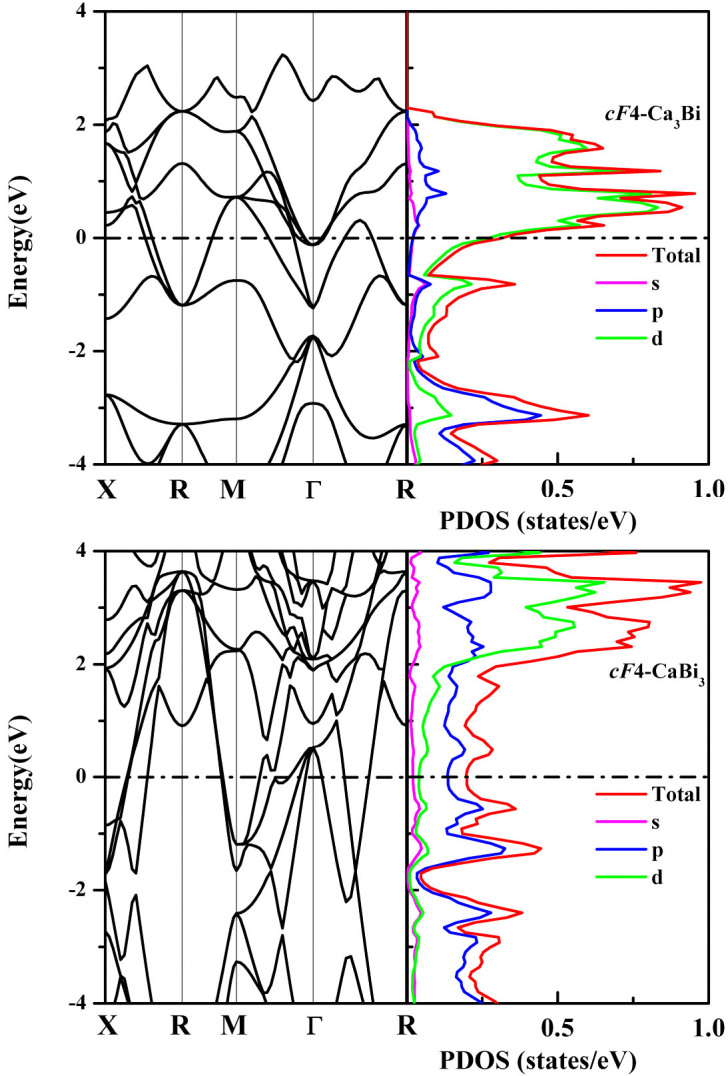
Band structure and partial density of states for cF4-Ca3Bi and cF4-CaBi3.